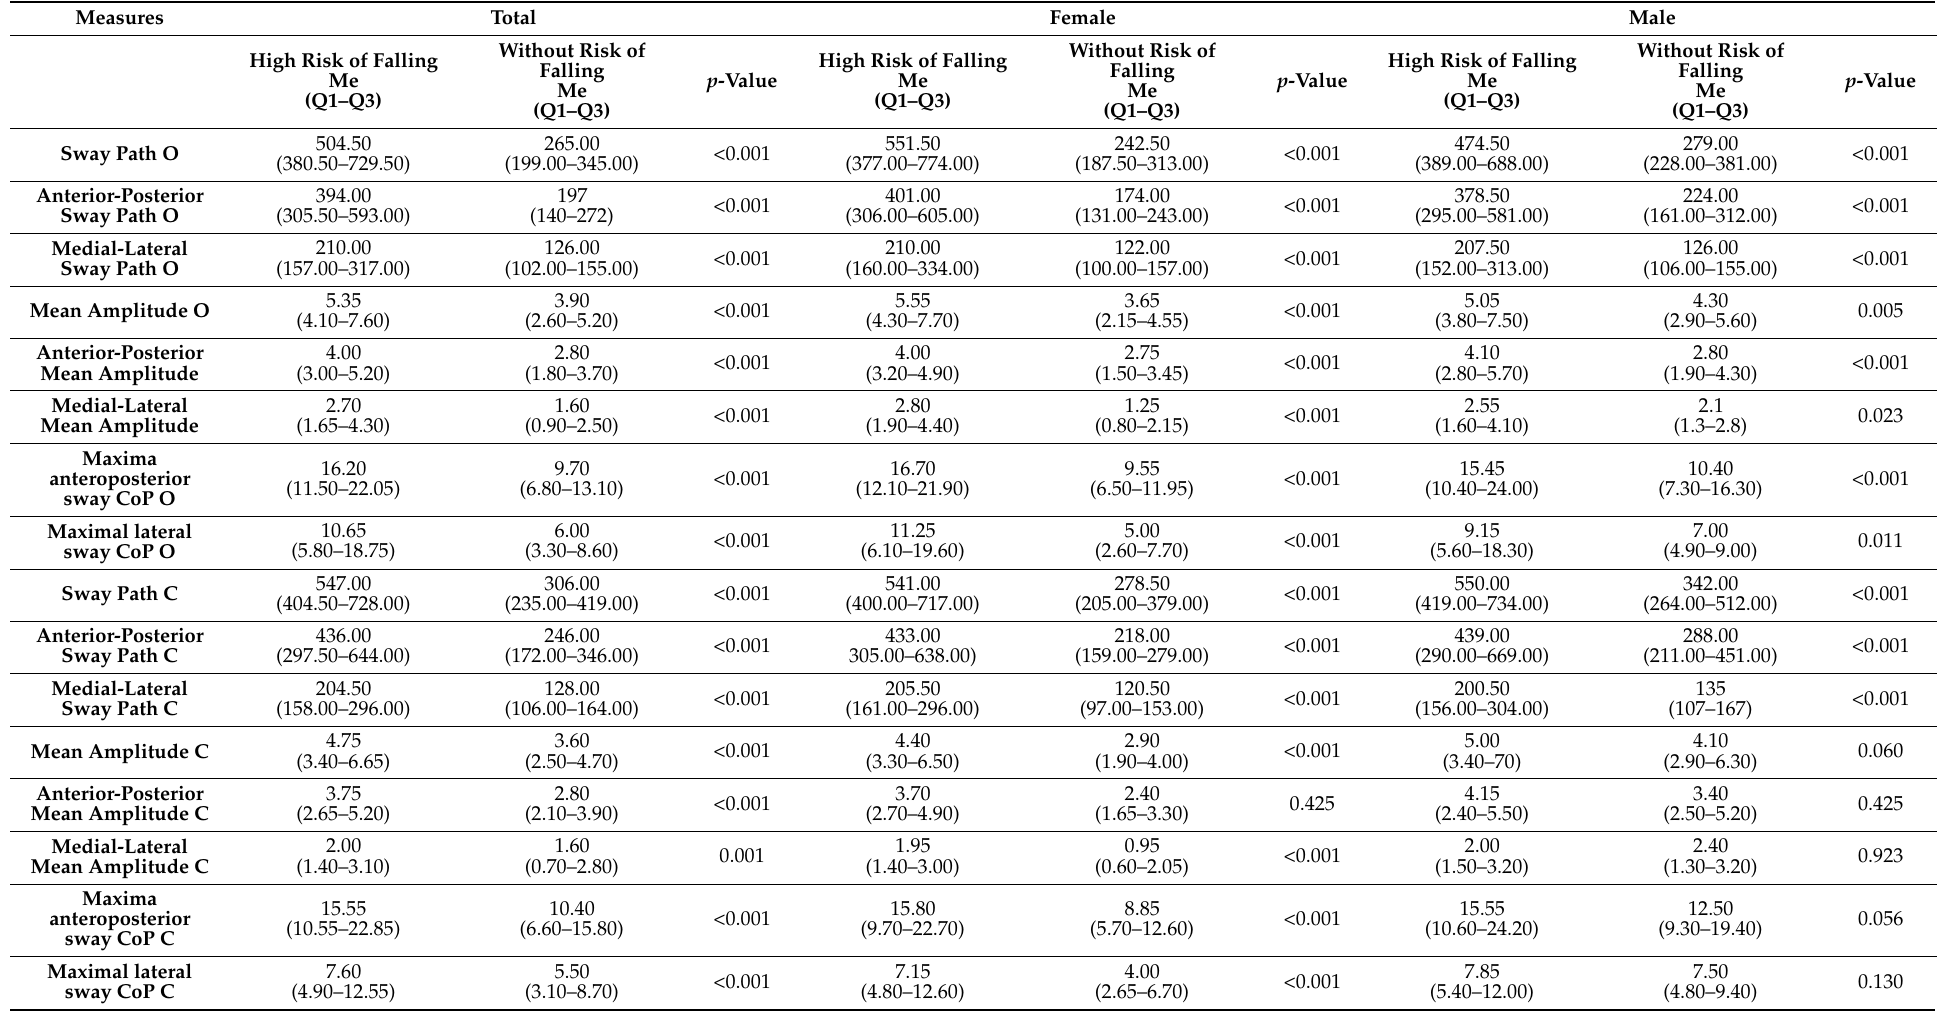
Table 2. Mean, standard deviation, and p -value for groups differing by the risk of falling under eyes open and closed